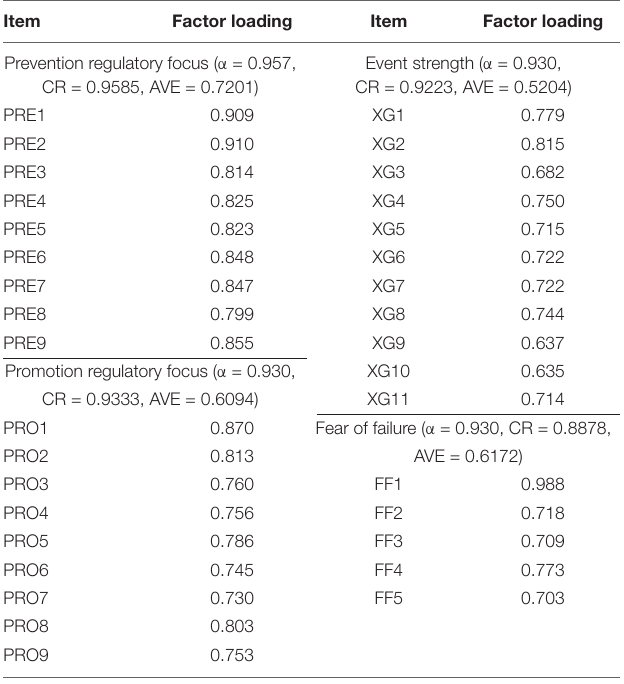
TABLE 2 | Reliability and